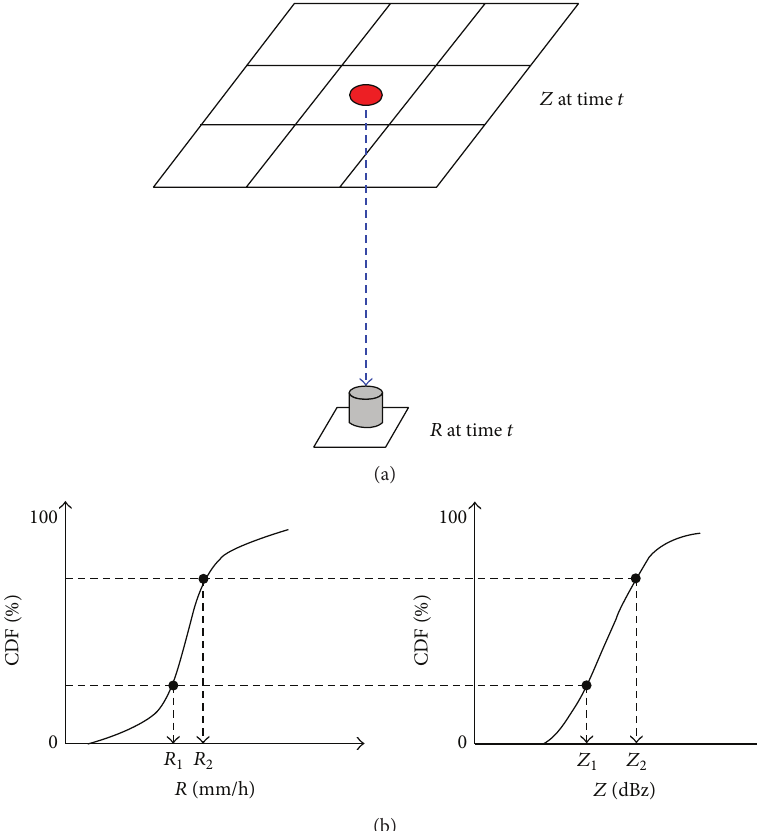
Figure 2: Relationship between (a) radar reflectivity and ground surface rainfall (b) cumulative density function of 𝑍 - 𝑅 matching method.